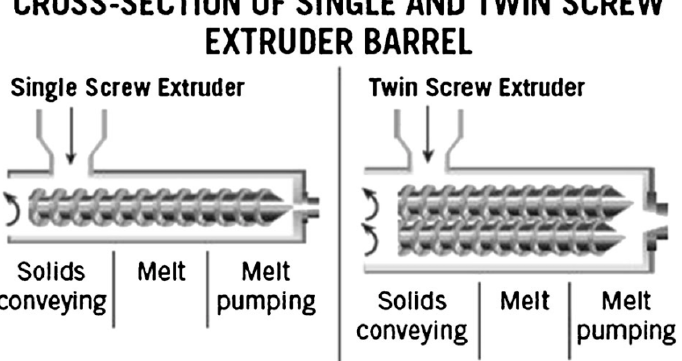
Figure 2. Cross-section of a single and twin-screw extruder (Reproduced with permission from reference [17] , Springer, 2015).